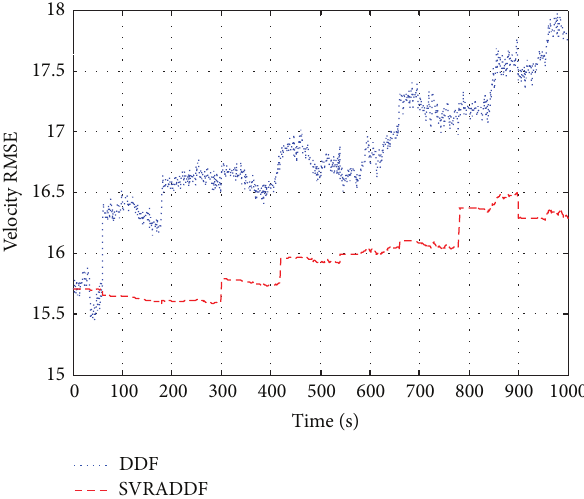
Figure 7: RMSE in velocity for DDF and